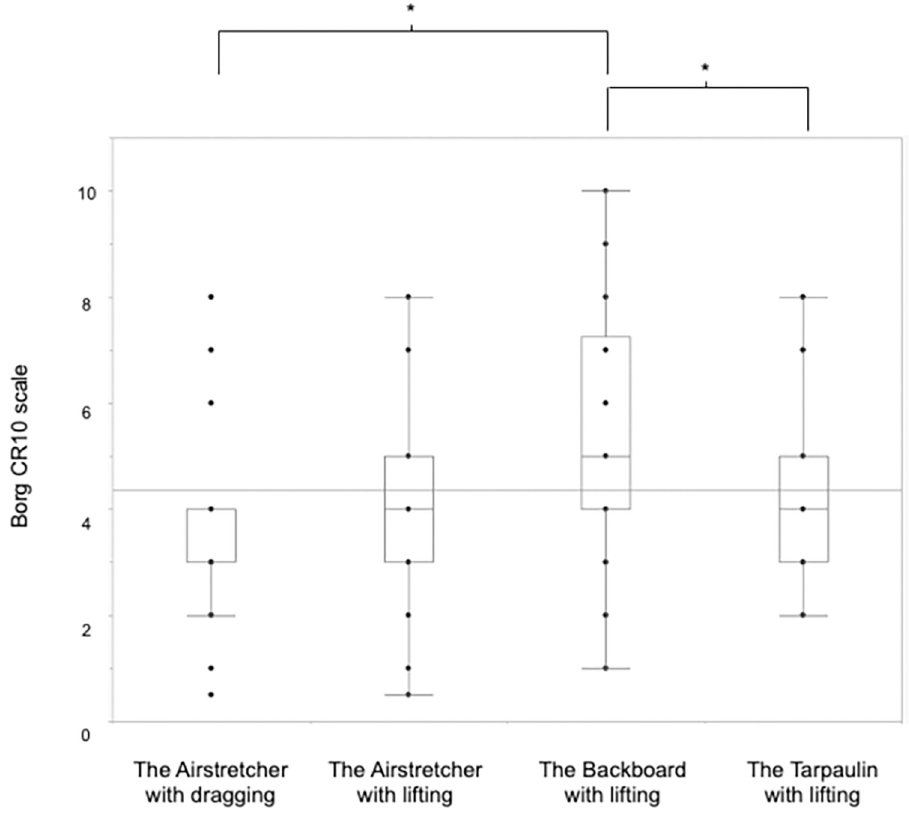
Fig 2. The Borg CR10 scale. � p < 0.01, Tukey-Kramer’s HSD test. https://doi.org/10.1371/journal.pone.0274604.g002 (0.4), 6.1 (0.3) and 4.7 (0.4) for the AL, BL and TL conditions, respectively, after adjusting for participant and duration time (F = 3.6, p = 0.02). Borg CR10 scores were lower in the AD con- dition compared with those in the AL condition ( p = 0.02) and the BL condition ( p < 0.01). Scores were lower in the TL condition compared with those in the BL condition ( p = 0.04).